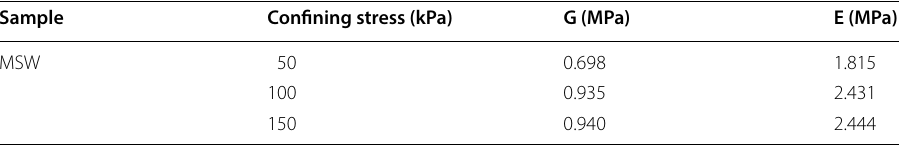
Table 2 The elastic constants obtained from direct shear test Sample